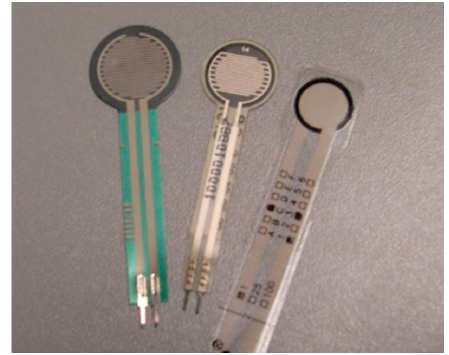
Figure 3. Three common types of FSRs: Interlink, LuSense, and FlexiForce [85].